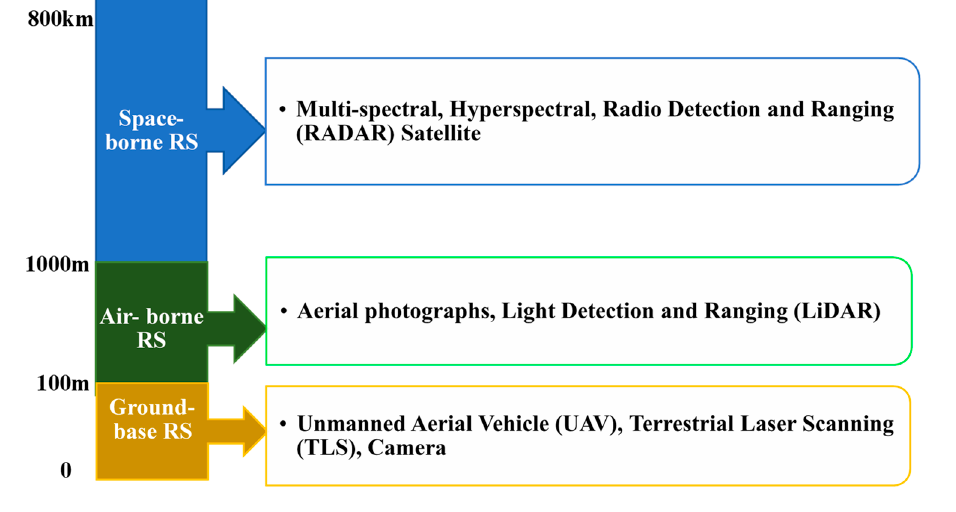
Figure 3. Remote sensing platforms for soil erosion hazard assessment. Table 1. Summary of temporal and spatial resolution adapted from Reference [97].